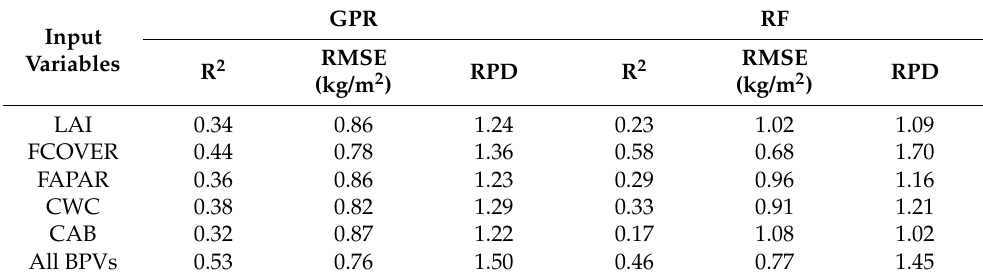
Table 5. Performance of S-2 vegetation biophysical variables on estimating maize biomass based on GPR and